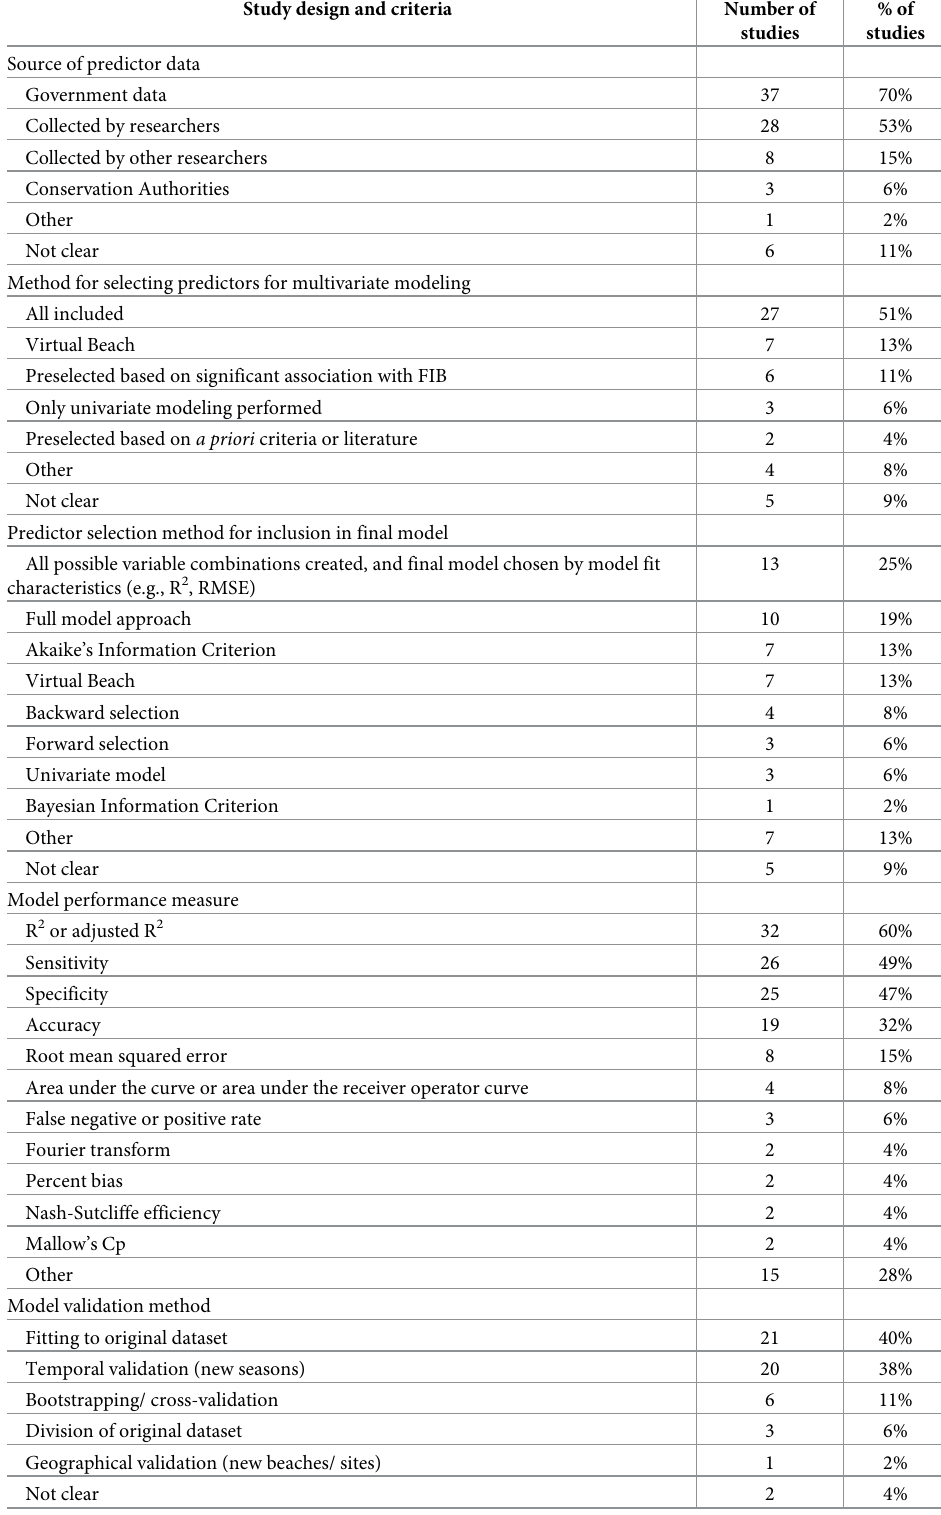
Table 3. Risk of bias checklist summary for 53 relevant